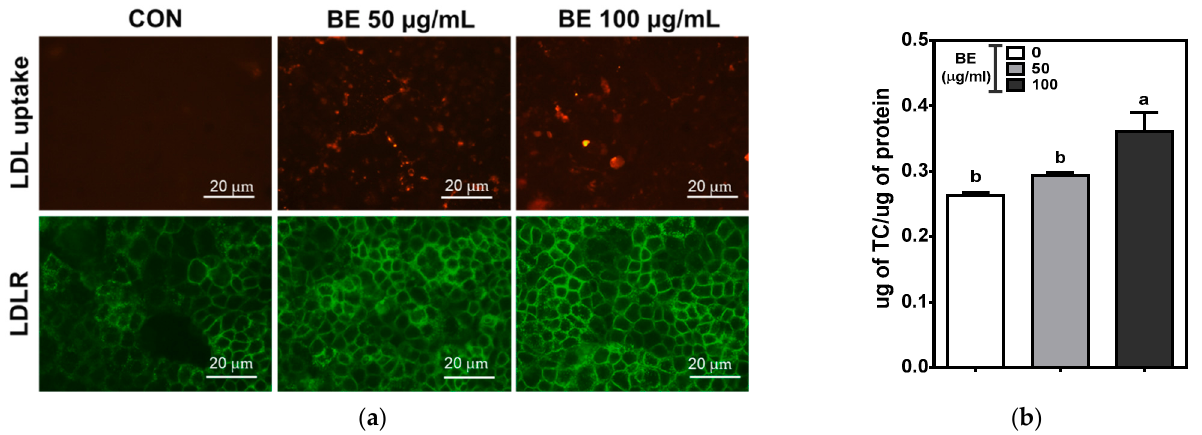
Figure 4. Cellular LDL uptake, LDLR distribution, and cholesterol levels in BE-treated Caco-2 cells. The cells were treated with 50 or 100 μ g/mL of BE for 24 h. ( a ) LDL uptake was measured by additional incubation with Dylight 550 fluorescent label LDL for 4 h. Immunofluorescent staining of LDLR was measured using LDLR Dylight 488-conjugated secondary antibody. Scale bar: 20 μ m. ( b ) Cellular total cholesterol concentration was measured enzymatically in the lipid extract of the cells. Bars with different letters are significantly different ( p < 0.05). Values are means ± S.E.M. n = 6.